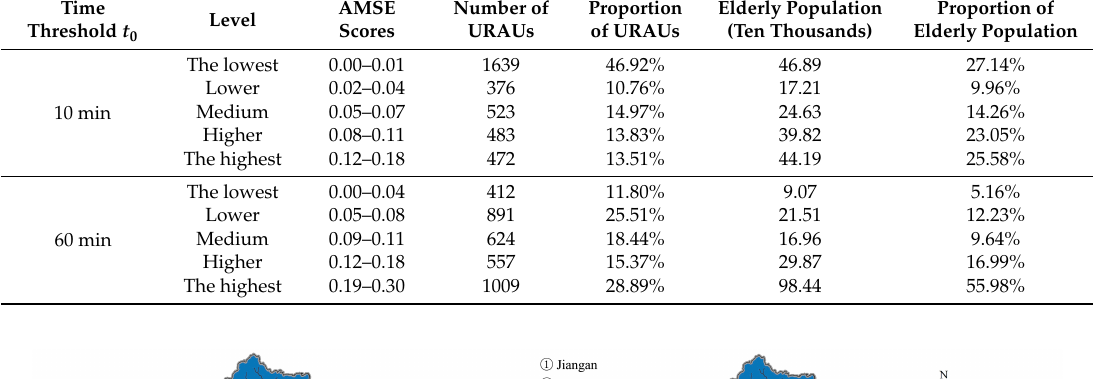
Table 3. Statistics and classification of accessibility of medical services for the elderly (AMSE) scores at